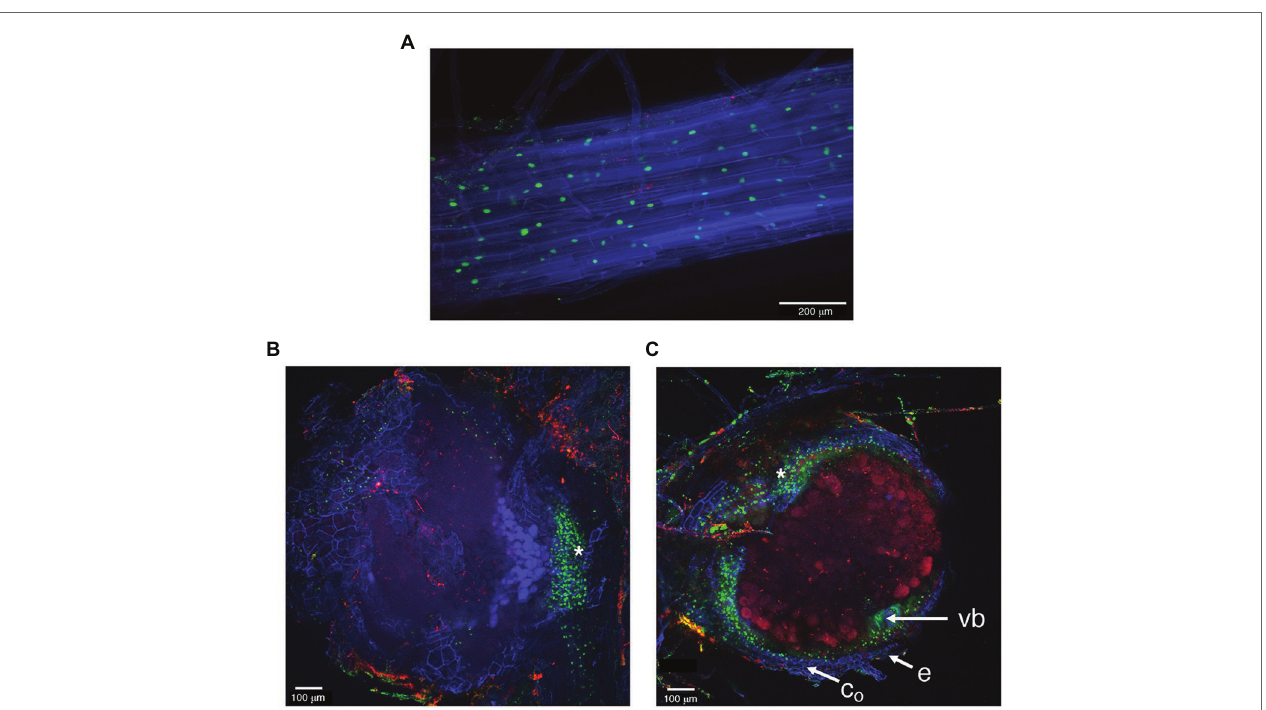
FIGURE 2 | The activity of LjNPF3.1 2.5-kb promoter fused to the tYFP-NLS reporter (nuclear-localized, green) in inoculated hairy roots. (A) Expression in the root cortical region. (B) Increased YFP fluorescence was detected at the base of mature nodules. (C) YFP fluorescence at the periphery of the N 2 -fixing nodules in the outer cortex region. *, nodule base; vb, vascular bundle; c o , outer cortex; e, epidermis.